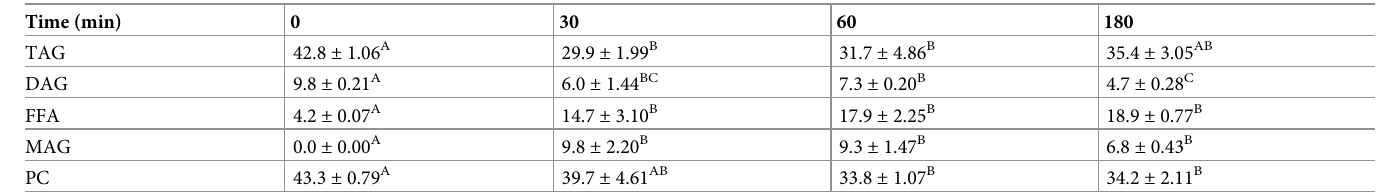
A,B,C (Results in the same row sharing superscripted letters are not significantly different (P � 0.01)). Triacylglycerol (TAG), diacylglycerol (DAG), free fatty acids (FFA), monoacylglycerol (MAG), phosphatidylcholine